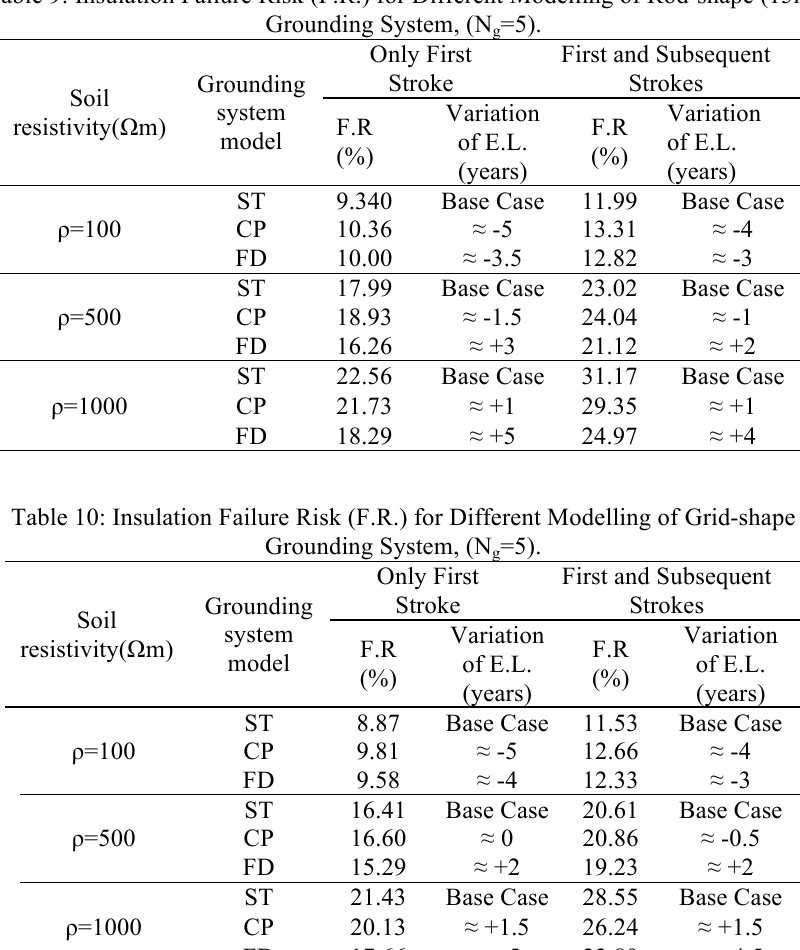
Table 9: Insulation Failure Risk (F.R.) for Different Modelling of Rod-shape (15m)